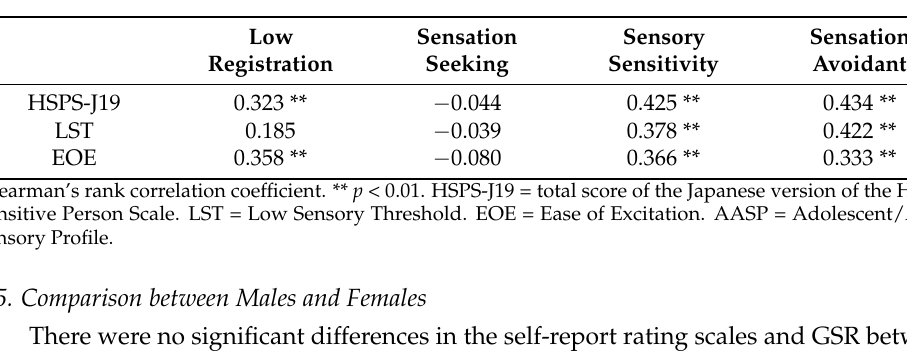
Sensory Sensitivity